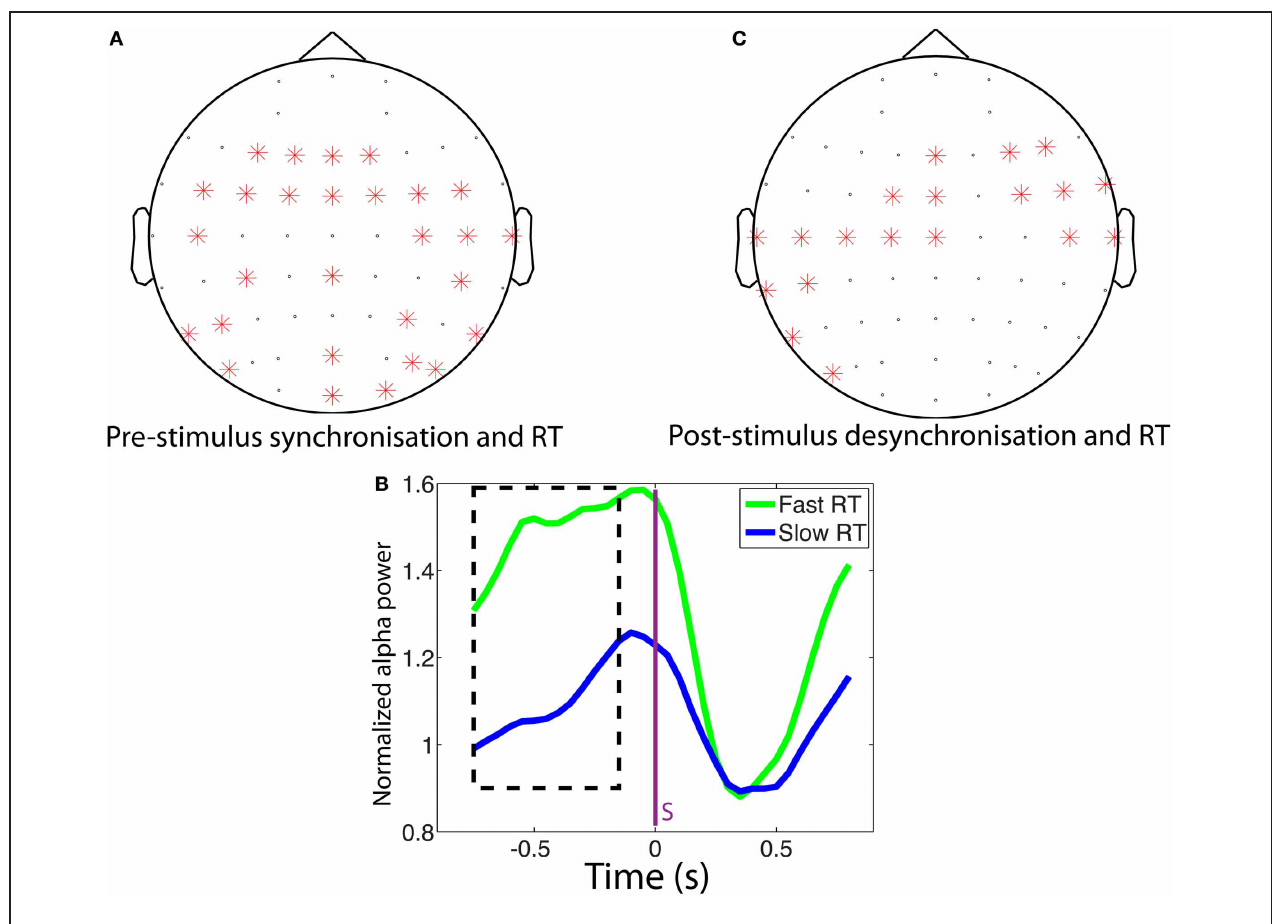
FIGURE 3 | Pre and post-stimulus alpha power correlate with reaction-time. (A) Electrodes highlighted with red stars are electrodes where a subject’s reaction-time was negatively correlated with normalized alpha power such that faster reaction-time is correlated with greater alpha ( p < 0 . 05, cluster corrected). (B) Descriptive graph of the effect observed in (A) showing average normalized alpha power time-course in those electrodes that showed a significant correlation with reaction-times. Time-courses are shown for two subgroups of participants, based on the median split of the reaction-time. Green line depicts the subgroup with the fastest reaction-times. Blue line depicts the